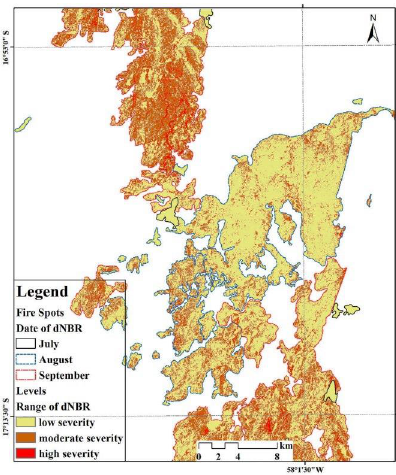
Figure 4. The comprehensive map of dNBR, 2019. Note: Figure 4 is the comprehensive map of the study area, including the monthly cut results (dNBR) in the burnt area between July, August and September.